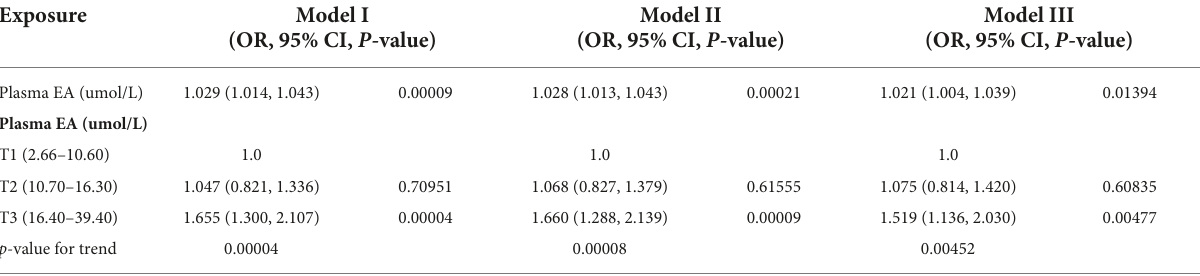
TABLE 2 Multivariate logistic regression model for association between plasma EA (umol/L) and moderate/severe periodontitis in different models.